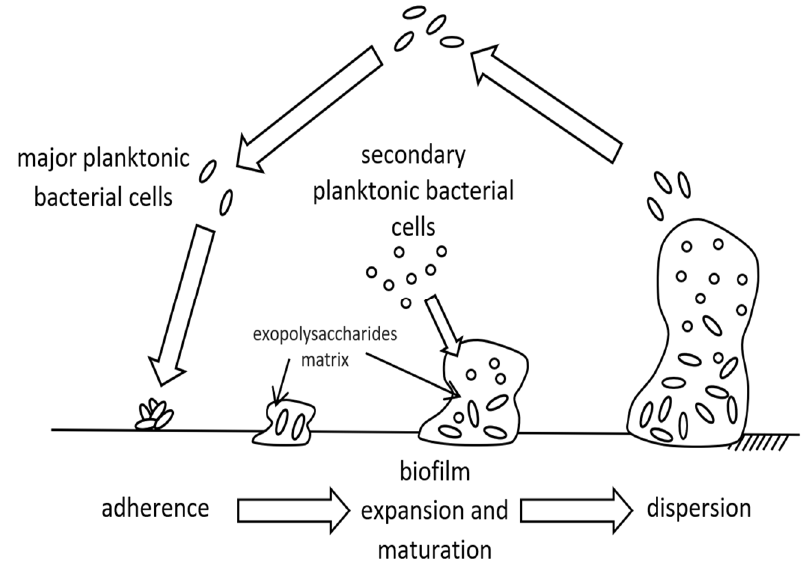
Figure 1. Subsequent stages of biofilm formation and microplastic surface colonization.